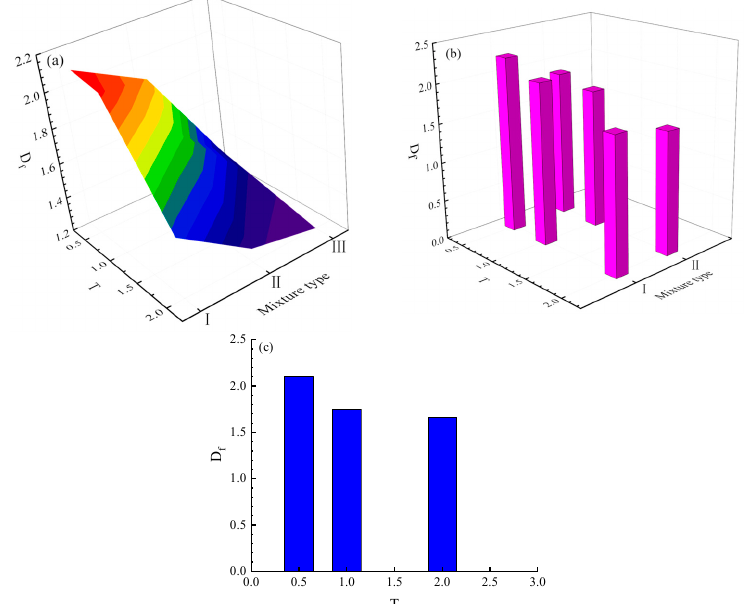
Figure 18. Dependence of the fragmentation fractal dimension on the particle size distribution (Talbot Index) and component mixture type: ( a ) Series 3; ( b ) Series 4; ( c ) Series 5.